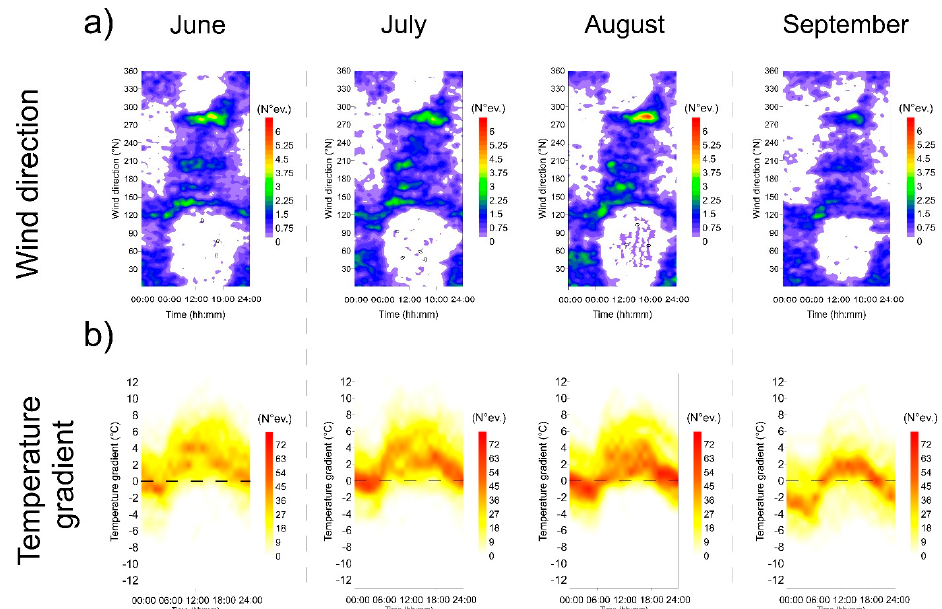
Figure 2. ( a ) Density plot of the daily distribution of the wind direction (2008–2014); the density plot was calculated for each degree and N° Ev. represents the number of events for the degree. ( b ) Air-sea thermal gradient during the summer months (2012–2014); the temperature gradient was calculated by subtracting the air temperature values, which were recorded at the weather station, from the sea temperature values that were recorded at the Water Quality Monitoring Station (Figure 1d).